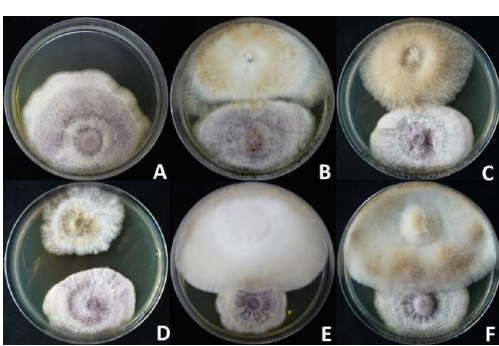
Fig. 3. Efficacy of Cyathus spp. controlling Fusarium sp. A: Fusarium sp. B: C.striatus KKU1 + Fusarium sp. C: C. striatus KU4 + Fusarium sp. D: C. earlei KKULP1 + Fusarium sp. E: C. stercoreus KKUITP2/KKULP2 + Fusarium sp. F: C. stercoreus KKUITP3/KKULP3 + Fusarium